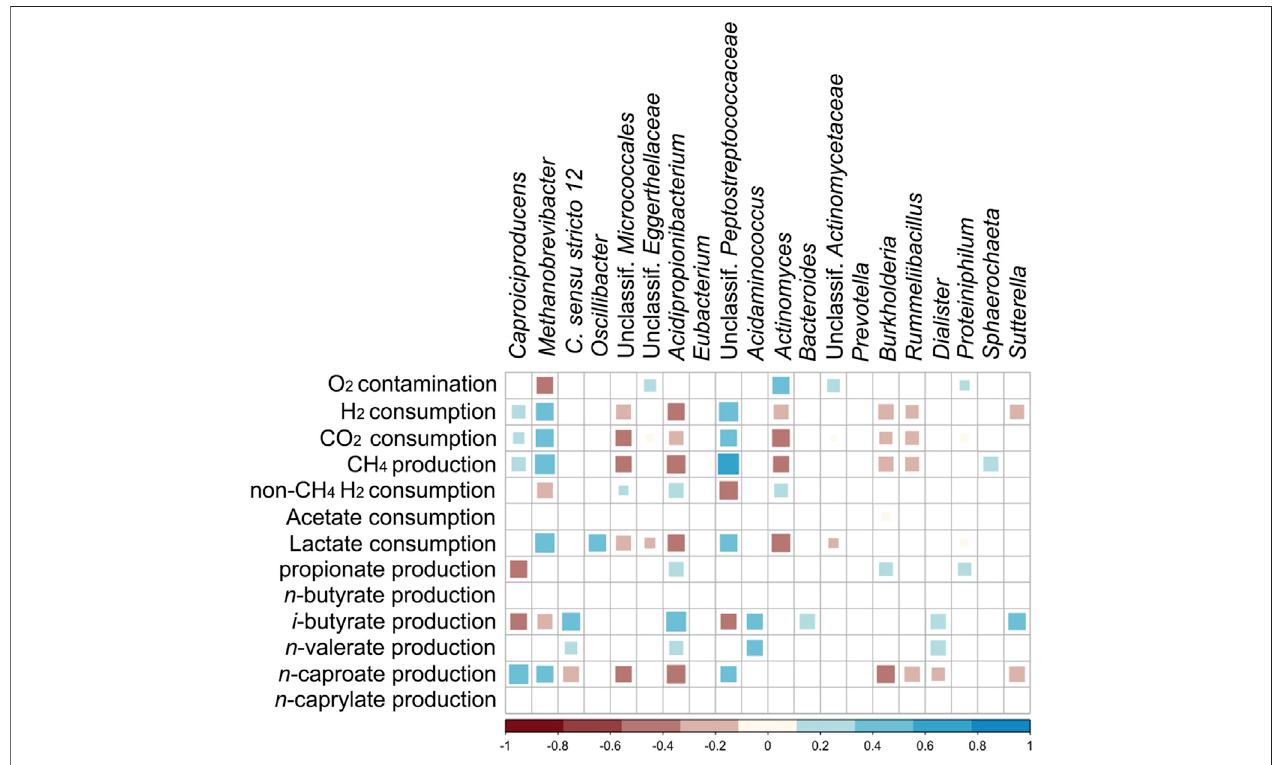
FIGURE 6 | Spearman correlation matrix between the most abundant genera, O 2 contamination rate, and production/consumption rates of chemicals ( p < 0.01). “ non-CH ” stands for H 4 H 2 consumption 2 consumption after discounting methane